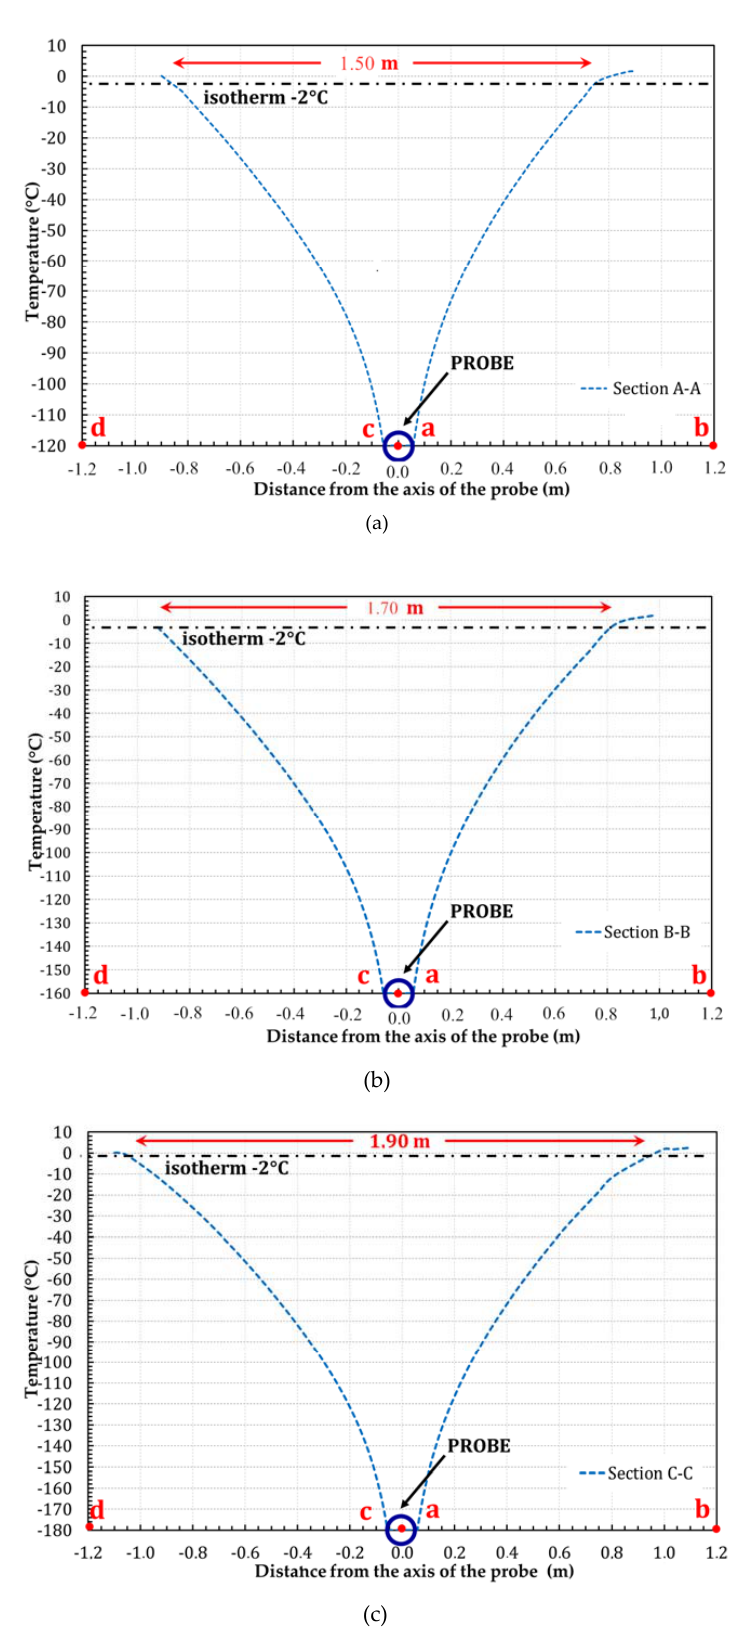
Figure 14. Temperature profile after 14 days of AGF with liquid nitrogen on segment a ‐ b at Section A ‐ A (a); section B ‐ B (b); section C ‐ C (c).